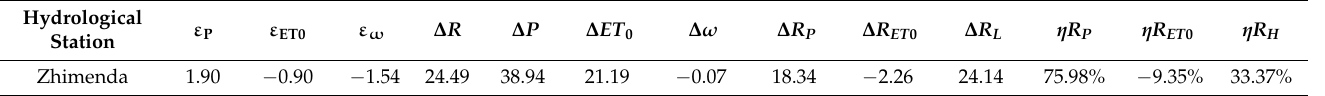
Table 2. Attribution analysis of runoff variation in the